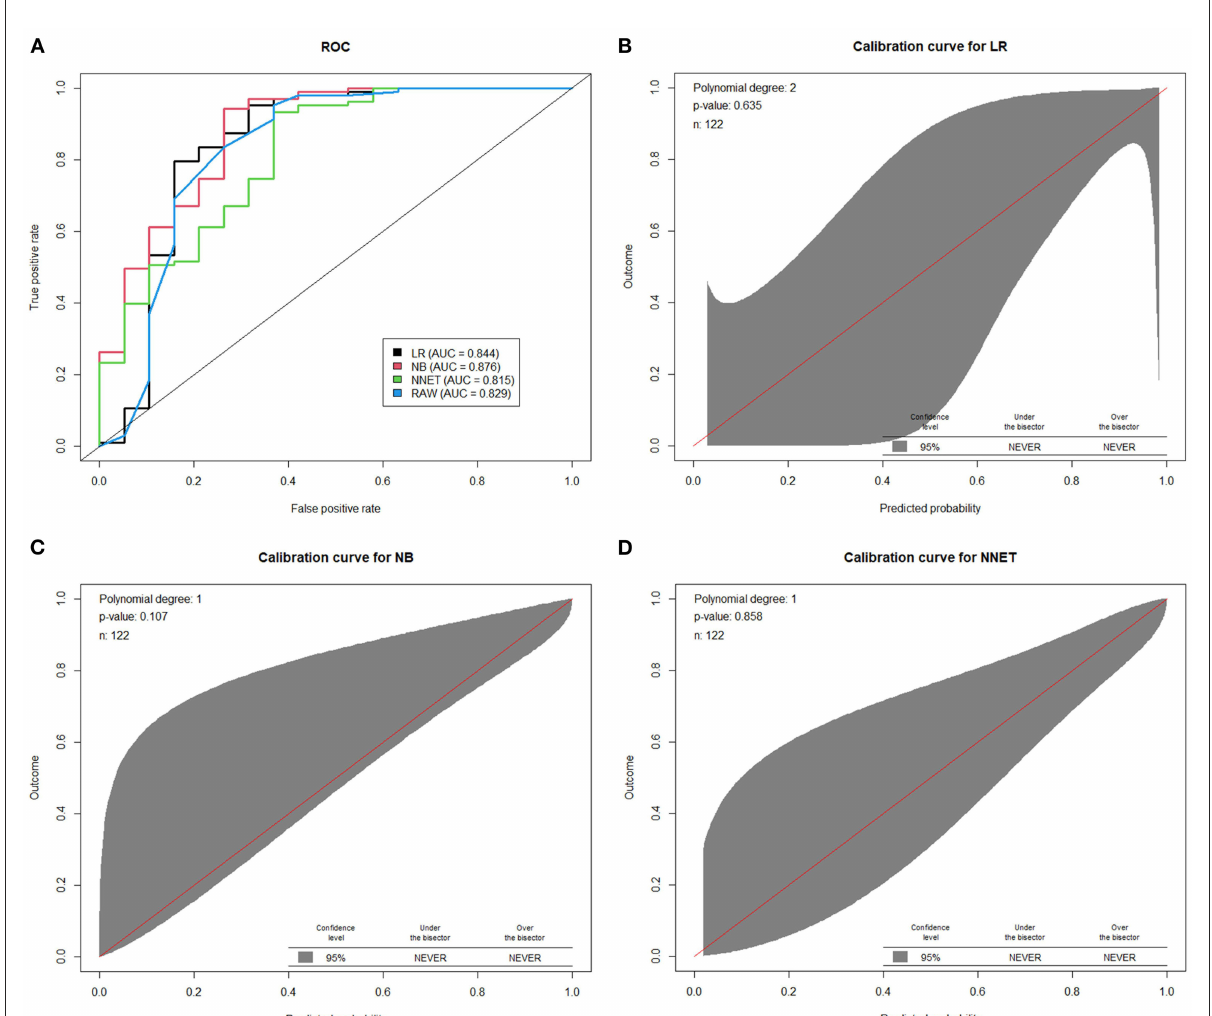
FIGURE3 The performance of machine learning models in the validation cohort. (A) Area under the curve of receiver operating characteristic curve by prediction models in the validation cohort. The calibration curves of logistic regression model (B) random forest model (C) and artificial neural network model (D) were presented. LR, logistic regression; BN, naive Bayes; NNET, artificial neural network; RAW, only Ct value at recurrence was included in the